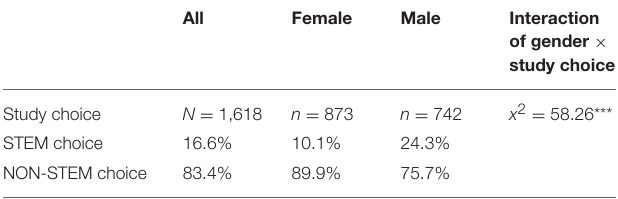
TABLE 2 | Study choice.